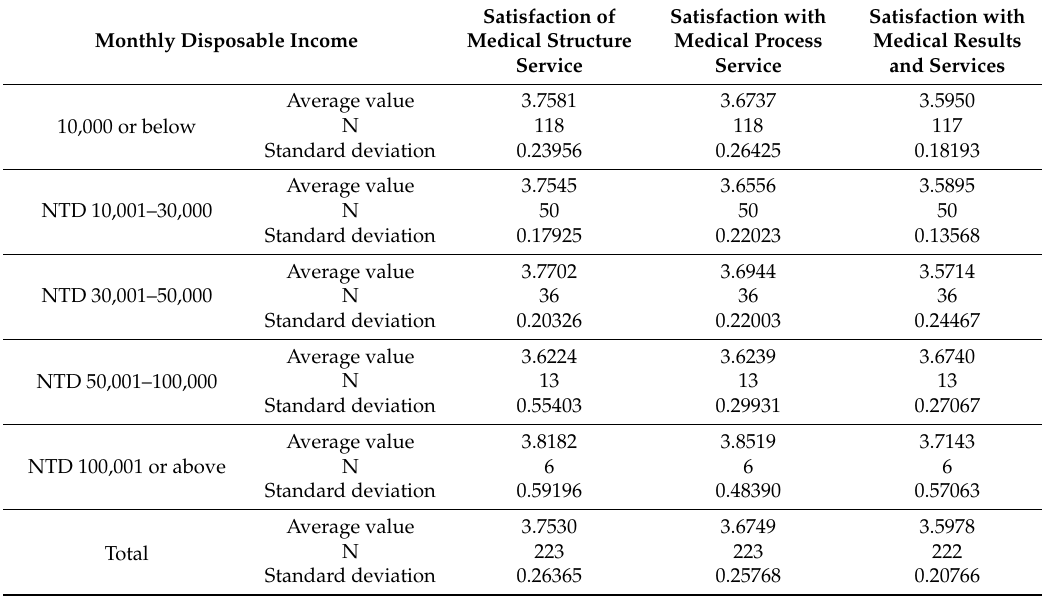
Table 19. Monthly Disposable